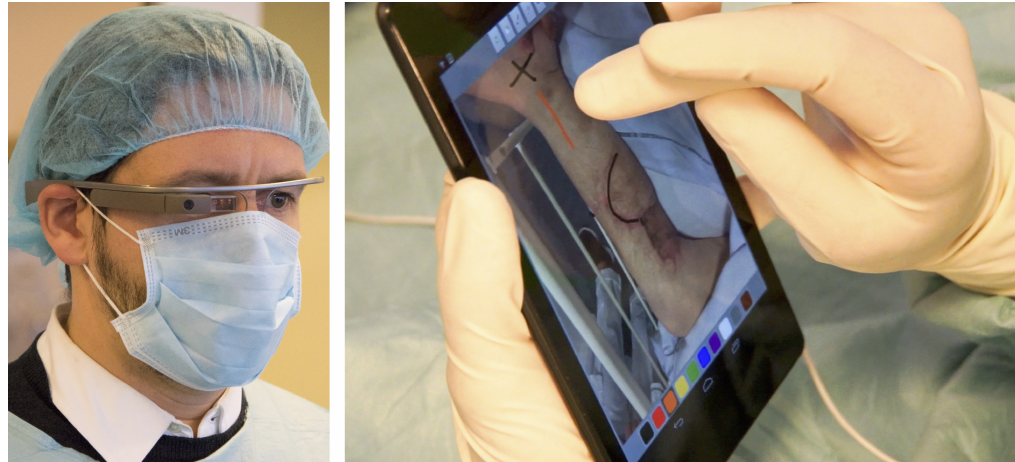
Figure 5. A remote surgeon (right picture) uses a tablet computer to provide guidance to the local surgeon (left picture). The local surgeon sees the visual guidance on the WPA Head-Mounted Display in real-time.